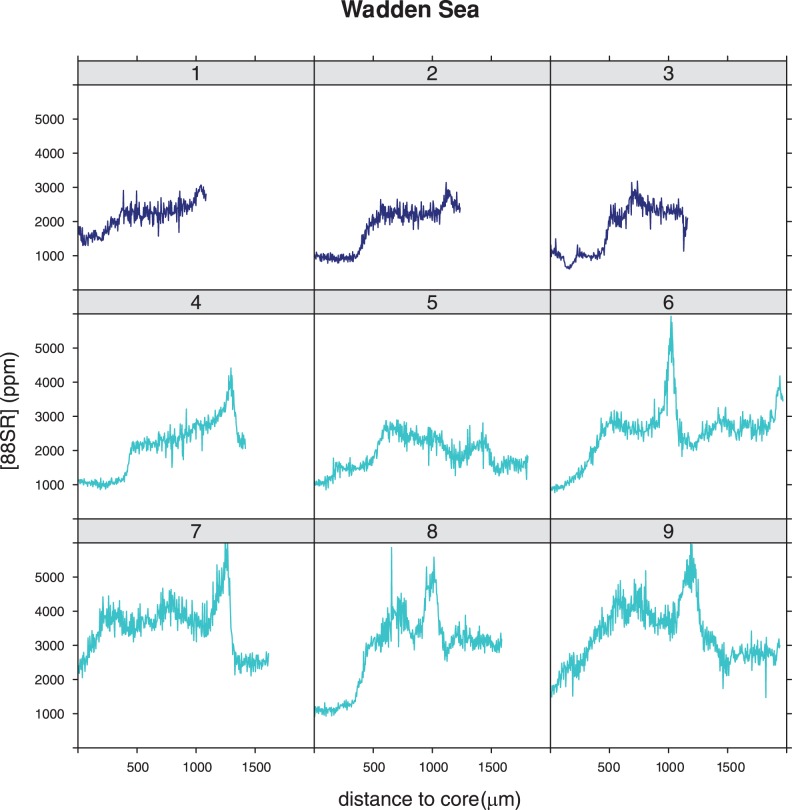
Strontium concentration profiles (in ppm) for smelt caught in the Wadden Sea, going from the nucleus (left) to the outer edge (right).The colours indicate the different hauls, all profiles in one colour originate from the same haul.